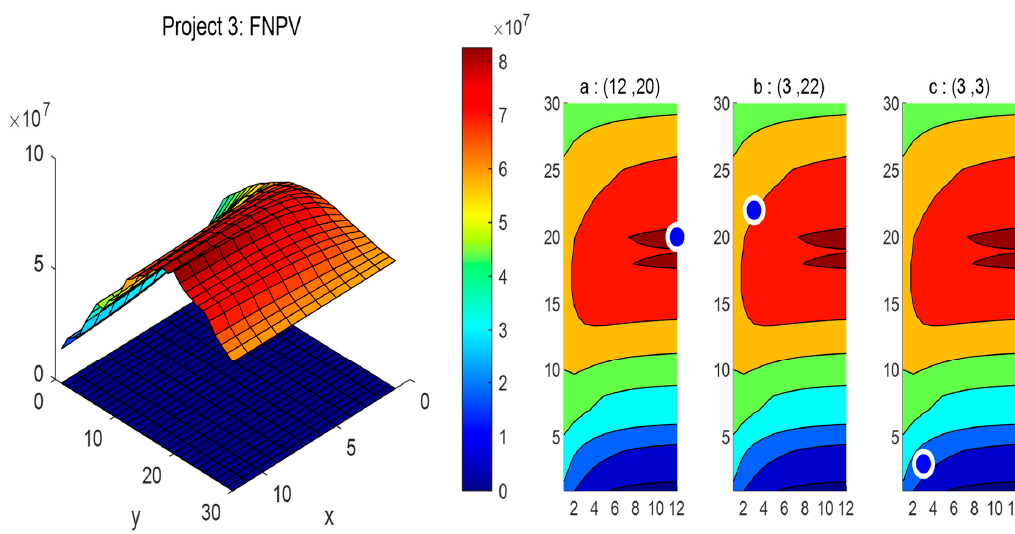
Figure A5. Decision − making for project 2. Figure A5. Decision-making for project 2.